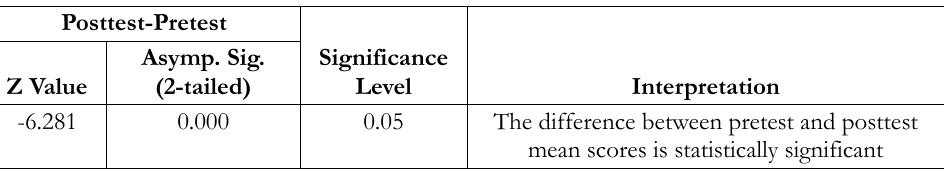
Table 9. The result of Wilcoxon Signed Rank